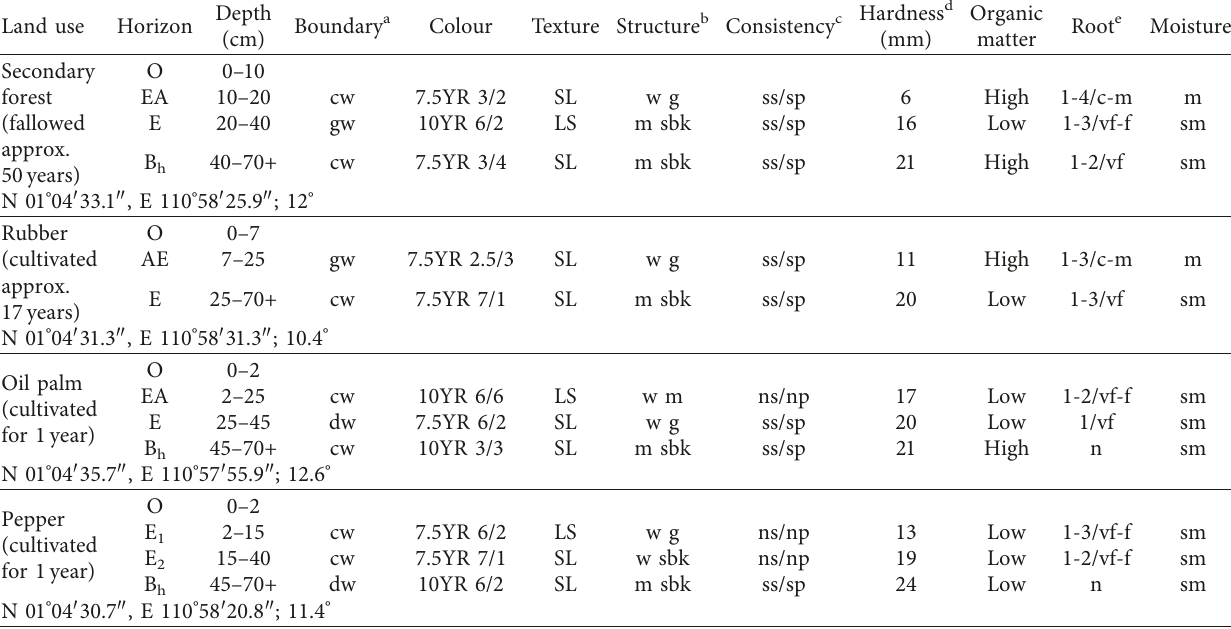
Table 3: Soil profile description of representative study sites from various agricultural land uses.